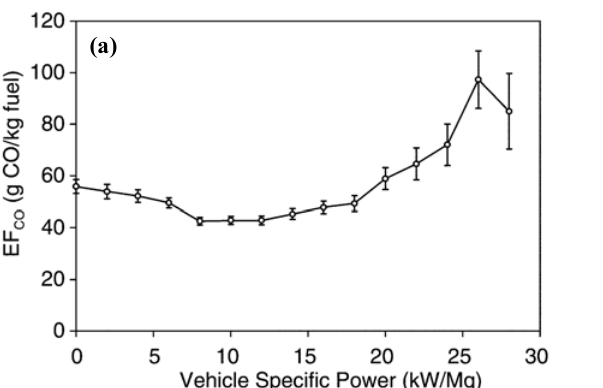
Figure 8. Panel ( a ) CO emission factors vs. the Vehicle Specific Power, panel ( b ) PM emission factors vs. the Vehicle Specific Power